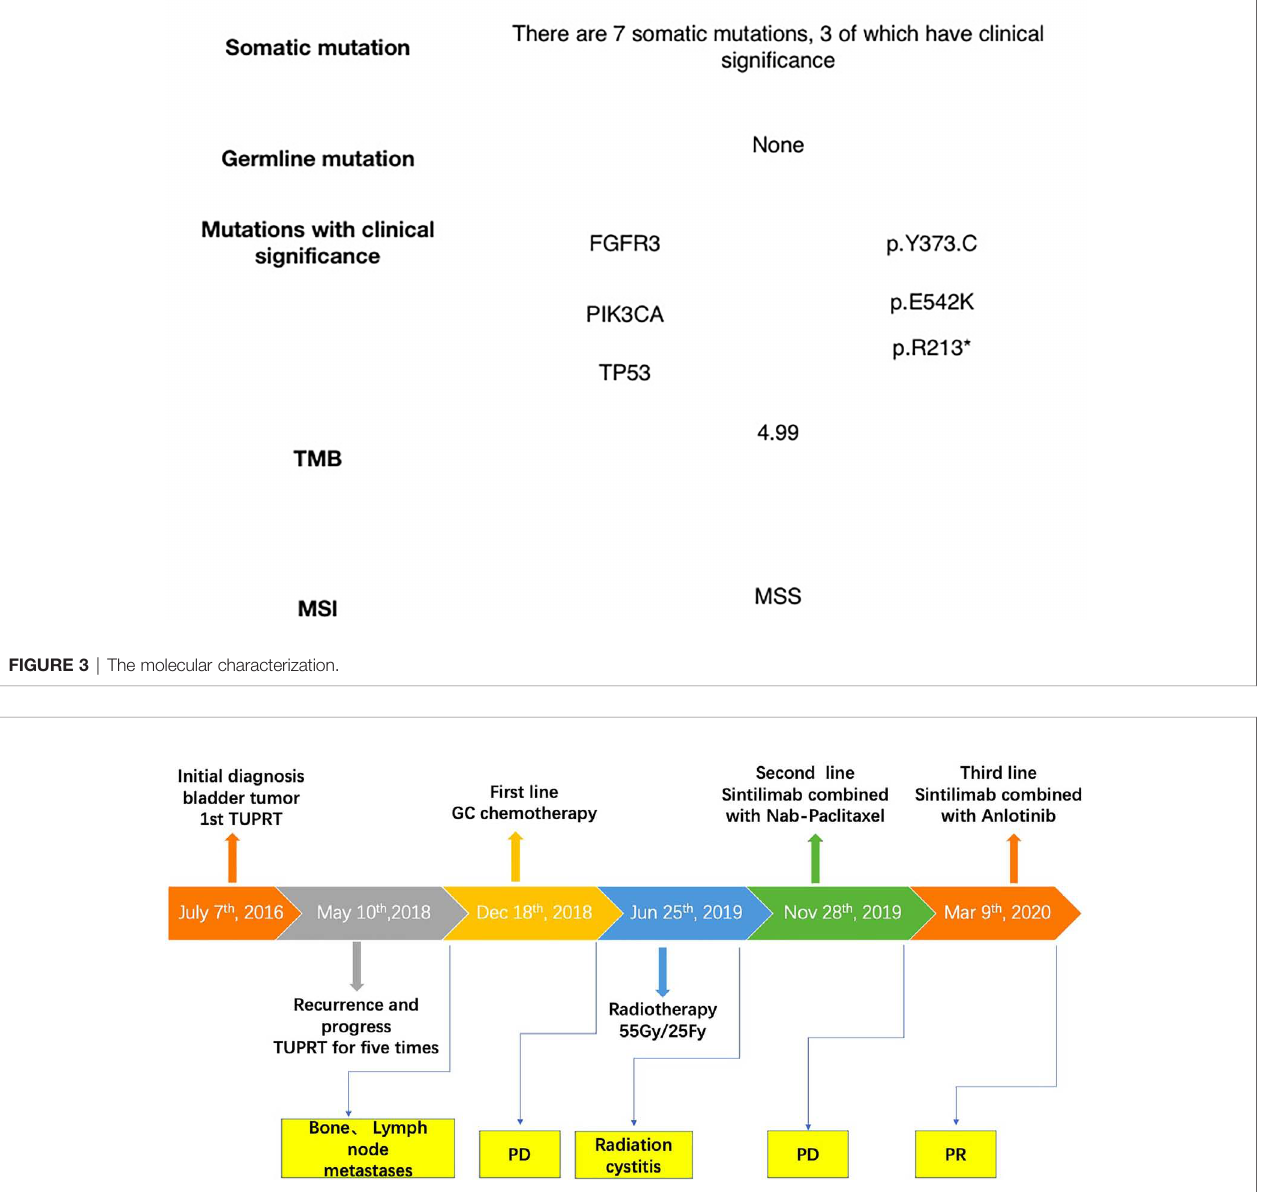
FIGURE 4 | The timeline of